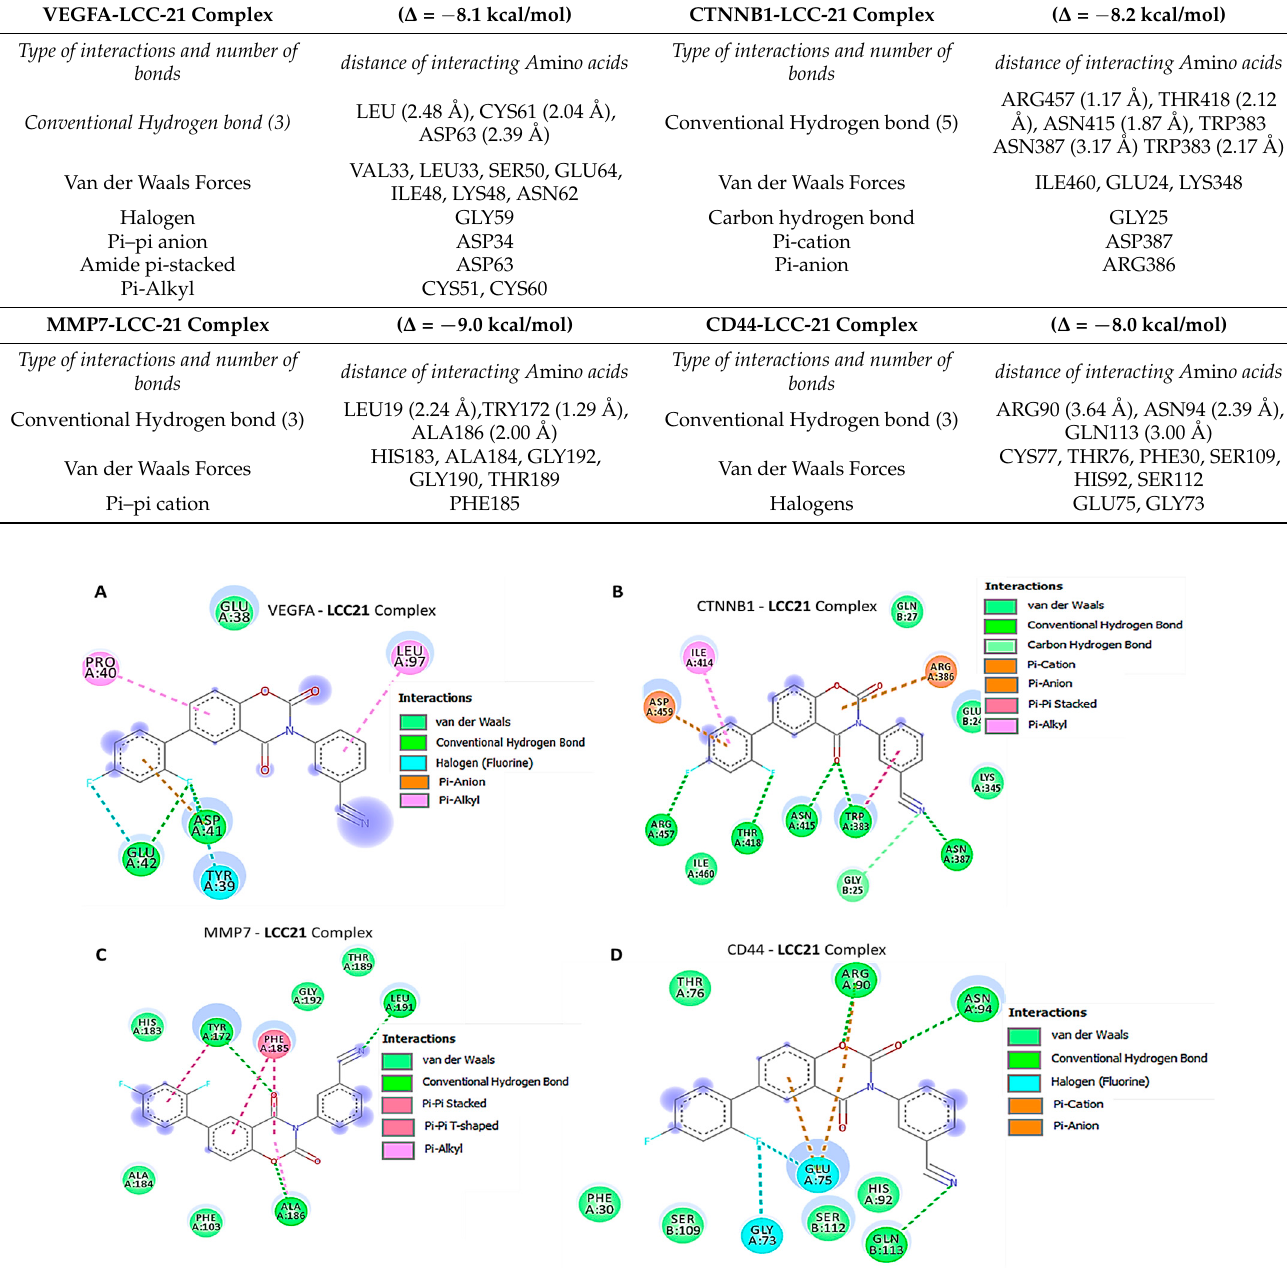
Figure 11. Two ‐ dimensional (2D) structural analysis using Discovery Studio showing ( A – D ) ligand– receptor interactions between the atoms involved in H ‐ bonding, amino acids and bond distances, van der Waals forces, carbon hydrogen bonds, and pi–pi interactions, with their respective amino acid of VEGFA/CTNNB1/MMP7/CD44 ‐ LCC ‐ 21 complexes using Discovery Studio (right). Table 2 summary of ligand–receptor interactions with their respective amino acids. 2. Analytical summary showing interactions of LCC ‐ 21 with VEGFA/CTNNB1/MMP7/CD44.